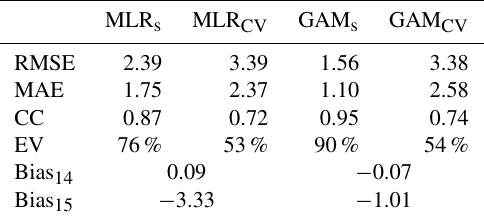
Figure 16. The temporal variation of measured (black) WHD NCP DY, MLR (red, a ) and GAM (red, b ) cross-validation fitted WHD NCP DY from 1980 to 2013. The results for 2014 and 2015 represent the measured (black square) and predicted (red hollow circle) WHD NCP DY. Table 1. The RMSE, MAE, CC and explained variance (EV) of MLR and GAM models, and predicted bias for 2014 and 2015. The subscripts S and CV indicated simple and cross-validation